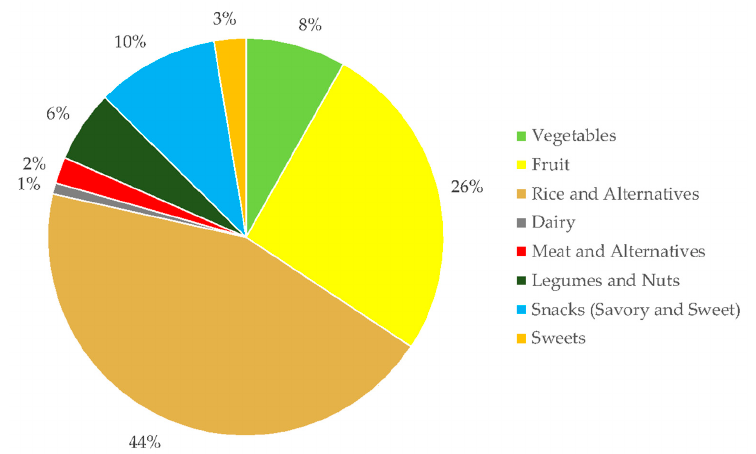
Figure 2. Percentage contribution of food groups to overall dietary fiber intake.